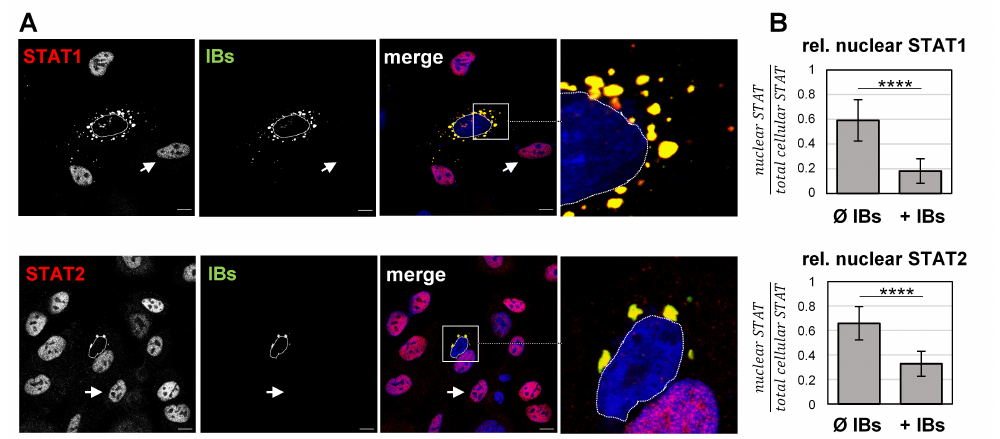
Figure 3. NiV IBs prevent nuclear translocation of STAT proteins after IFN treatment. ( A ) A549 cells were transfected with plasmids encoding NiV N and NiV PeGFP for 22 h to induce IB formation. Then, cells were treated with 1000 U/mL of human IFN- β for 40 min and fixed with PFA. After permeabilization with Triton X-100, endogenous STAT1 and STAT2 proteins were stained with specific antibodies (red). IBs were detected by eGFP autofluorescence (green). Nuclei were counterstained with DAPI (blue). Boxed areas are displayed in a higher magnification and show the STAT accu- mulation in IBs in a NiV N/P-expressing cell. Arrows point to the nucleus of a non-transfected cell without IBs. The dashed lines label the nuclei of IB-containing cells. Scale bars, 10 µ m. ( B ) To quantify the relative STAT fluorescence in the nucleus, the total cellular fluorescence as well as nuclear signal intensities of STAT1 or STAT2 were quantified in at least 300 cells. The ratio of nuclear to total cellular fluorescence in cells without IBs (Ø IBs) and with IBs (+IBs) is shown (relative nuclear STAT). Error bars indicate standard deviation (SD); **** p <